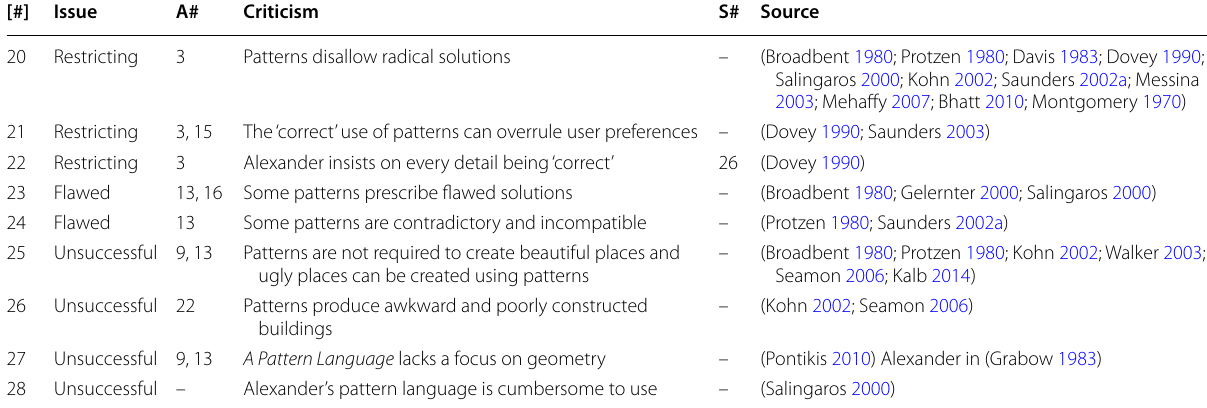
Table 3 Criticisms of Alexander’s second theory of architecture: implementation and